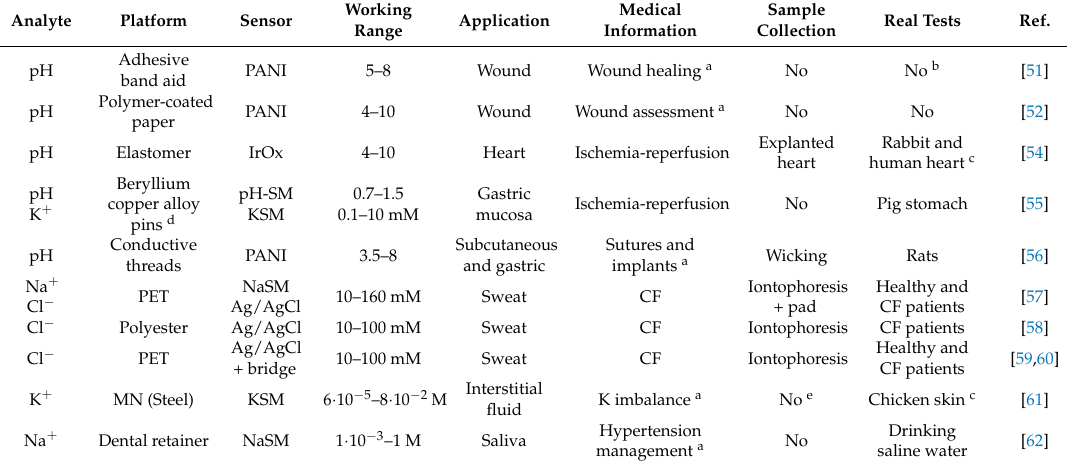
Table 1. Description of recently reported wearable potentiometric sensors that have been employed for medical